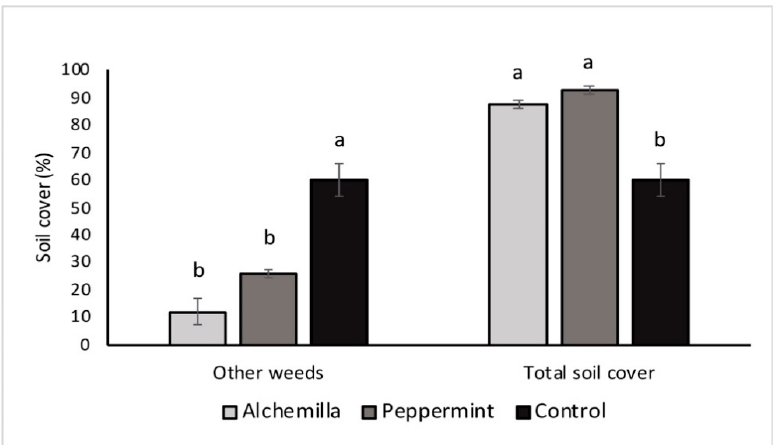
Figure 2. Effect of living mulching species on percentage of soil coverage by weeds and total vegetation. Bars represent the SEM. Bars with different letters are significantly different at p ≤ 0.05 (Tukey–Kramer HSD test).